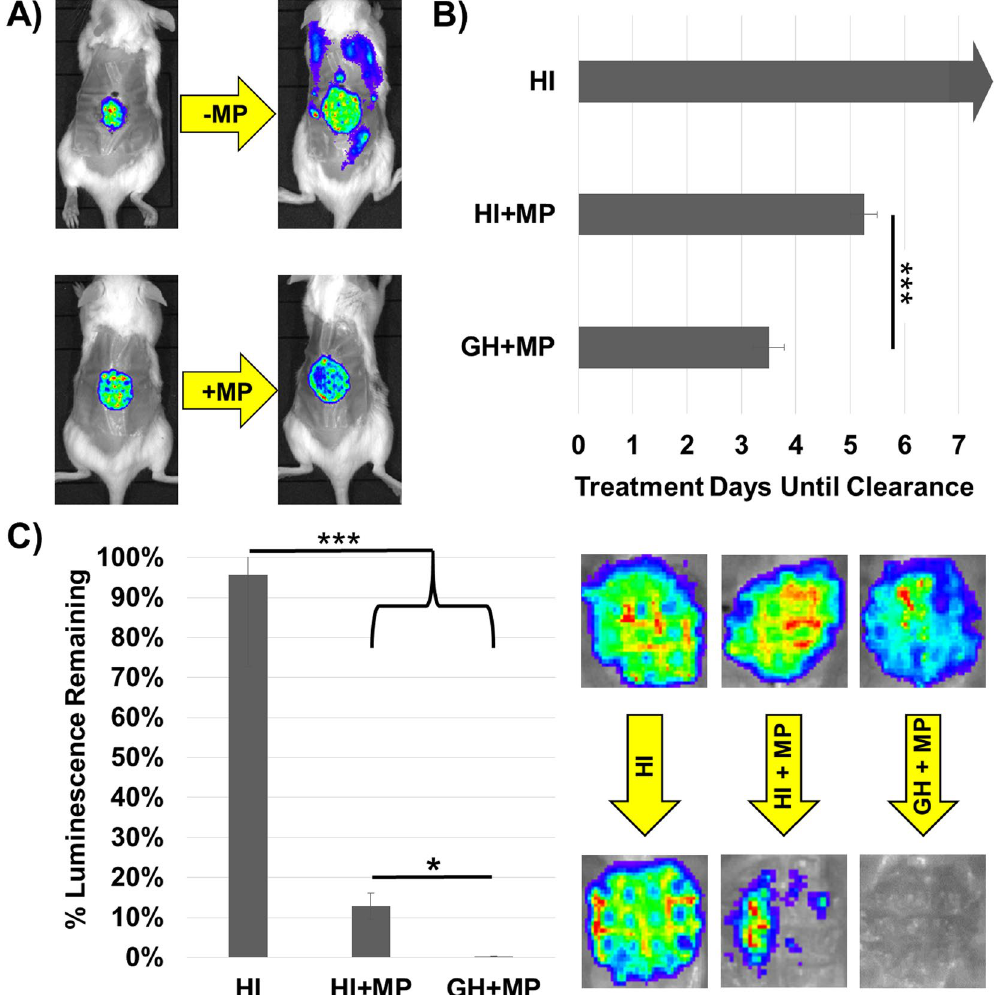
Figure 4. Antibiotics protect against dispersal-induced septicemia, and GH treatment augments antibiotic efficacy. Topical or systemic (pictured) meropenem (MP) protected against 10% α -amylase and cellulase (1:1; GH) dispersal-induced septicemia ( A ). Wounds were treated with heat-inactivated (HI) enzyme control, with or without concurrent topical MP (3 mg/ml) every 24 hours for 3 days, starting at hour zero. GH therapy significantly improved infection clearance vs. MP and HI enzyme. Treatment days until clearance” refers to the number of days until luminescence was reduced to zero ( B ). Luminescence quantification and representative IVIS images of wound-beds on treatment day 3 showed complete clearance of enzyme plus antibiotic treated wounds ( C ). One-way ANOVA and the Tukey-Kramer multiple-comparison test were used to test for differences between columns: * p < 0.05 *** p < 0.001. N = 9 for each